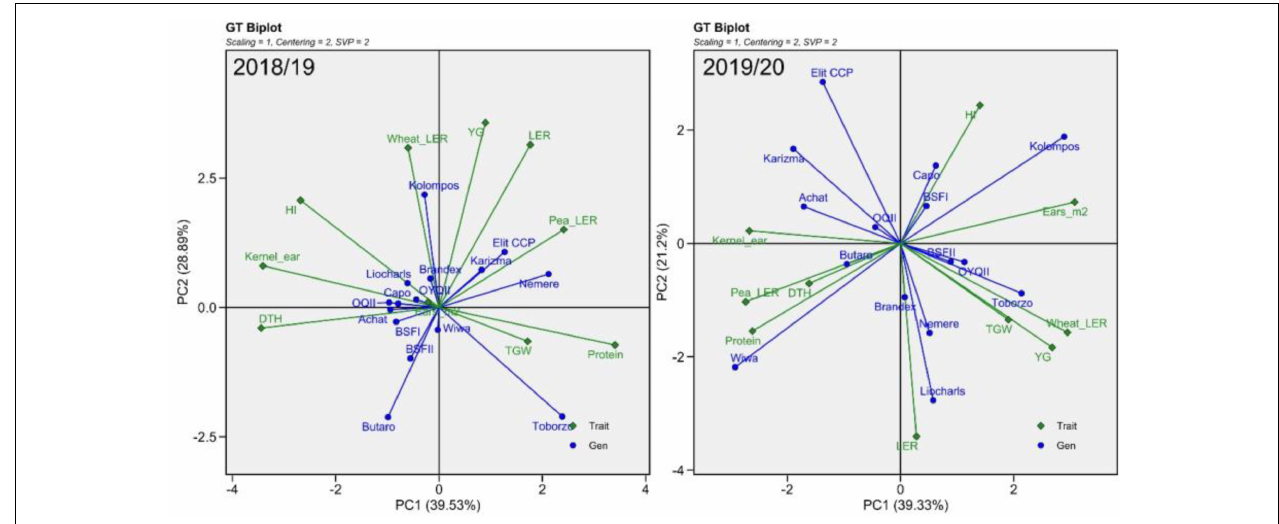
FIGURE 9 | Genotype by trait biplots for two seasons. Entries are indicated in blue and traits in green.